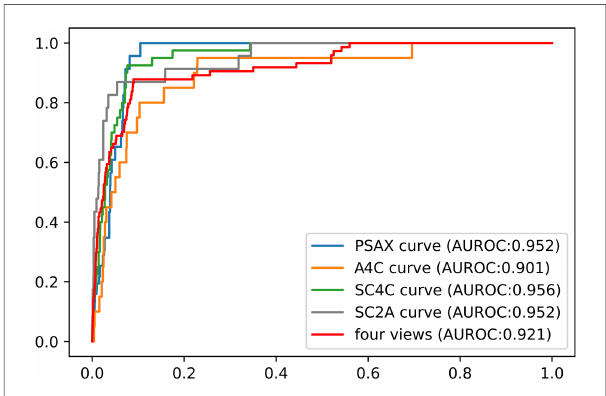
FIGURE 4 The performance of ASD detection model in the external dataset. The performance of composite classi fi er model (red curve) had an AUROC of 0.92. Abbreviations as in Figure 1